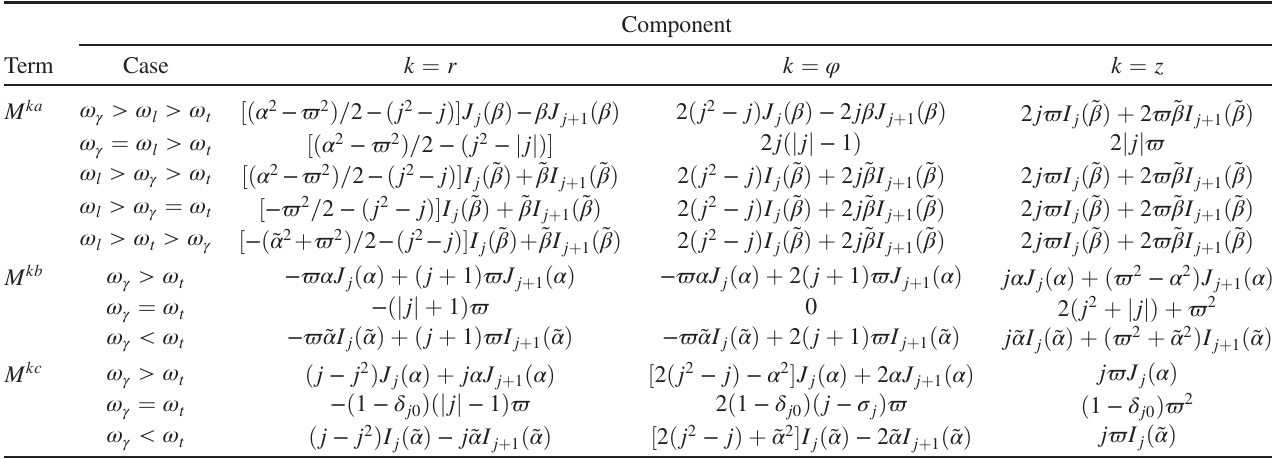
TABLE XI. Fiber eigenmodes: Terms in the radial partial wave T γ of the stress modal field in Eq. (C19). The terms are evaluated on the fiber surface ( r ¼ R ) and correspond to the matrix elements of M in the boundary condition Eq. (C20) and frequency equation (C21). All remaining quantities are defined in Table